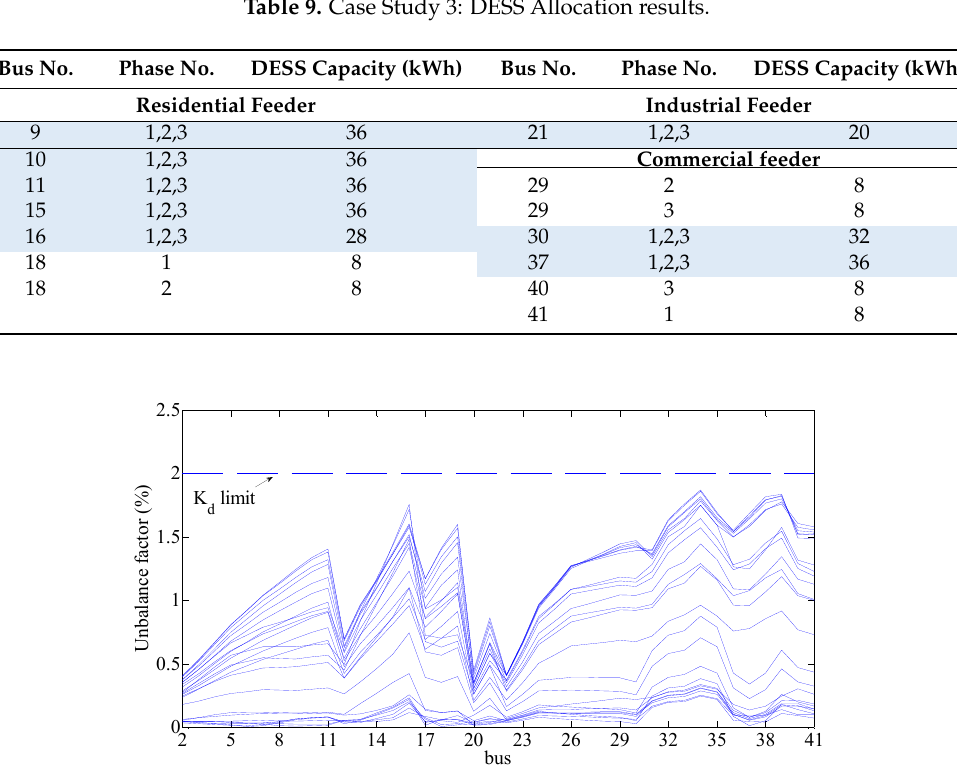
Figure 11. Case Study 3: Line currents of the residential feeder (phase no.1) at hour 21.00 of the last typical day.